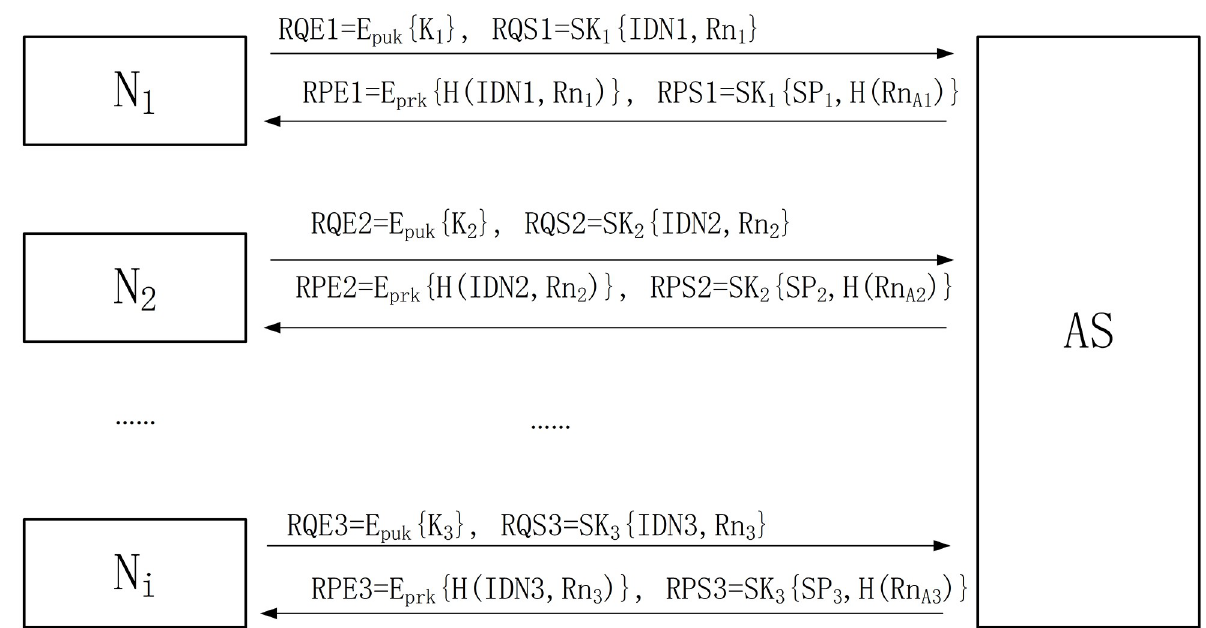
Fig 1. The working process of the registration